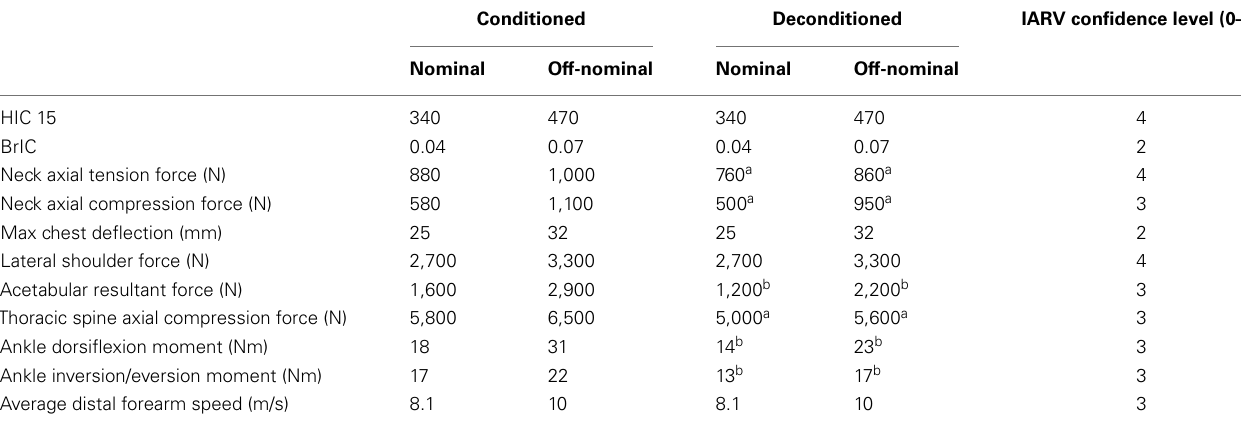
Table 6 |Table of proposedTHOR injury assessment reference values (IARV).